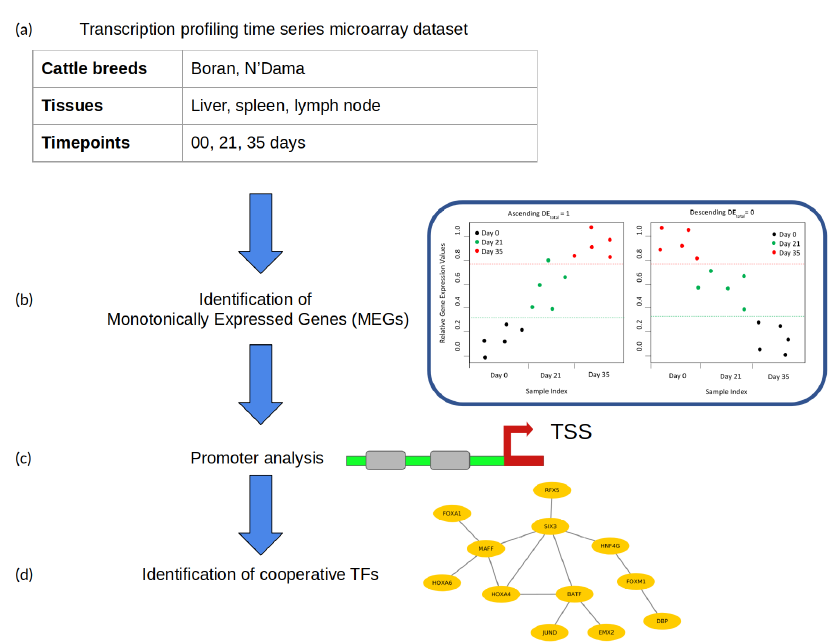
Figure 1. Flowchart of analysis. ( a ) Processing of the microarray dataset; ( b ) identification of Monotonically Expressed Genes using the MFSelector approach; ( c ) promoter analysis (TSS: transcription start site); ( d ) identification of cooperative TFs using PC-TraFF